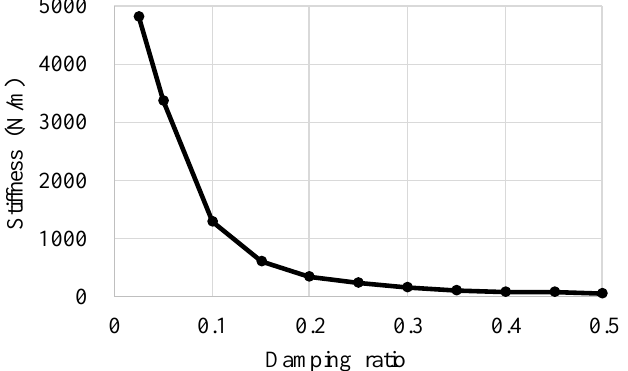
Figure 3. The matching curve of radial composite stiffness-damping rate of the vibration damping system.